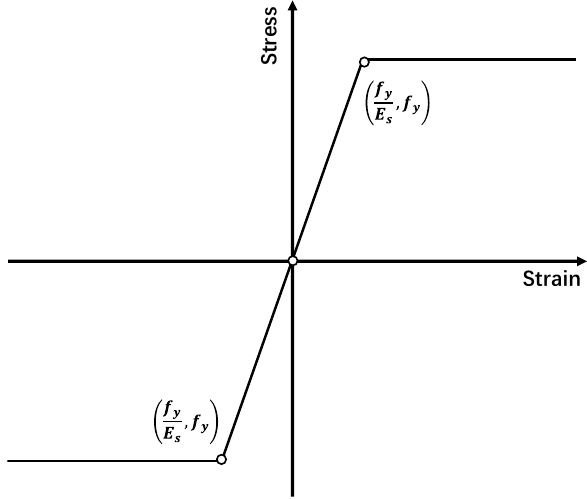
Figure 7. Stress–strain relationship of steel bars.